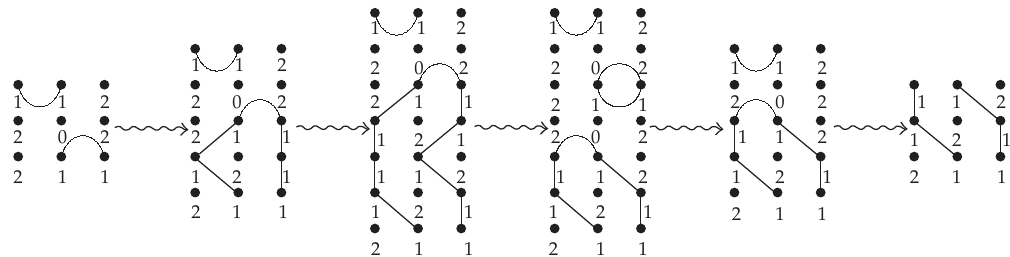
Figure 15: Tangles for compositions of natural transformations in the (cid:2) 2 , 1 , 1 (cid:3)